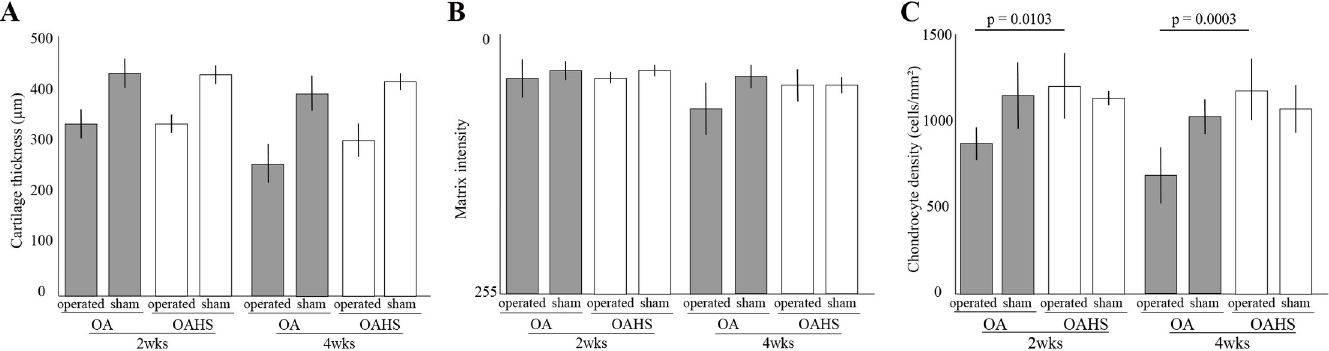
Fig 4. Results of histomorphological changes in the articular cartilage. (A-C) present cartilage thickness, staining intensity, and cell density, respectively. No significant differences in cartilage thickness and matrix intensity of the operated limb were found between the two groups at 2 and 4 weeks. Cell density of the operated limb in the OA group was significantly less than that in the OAHS group at 2 and 4 weeks.